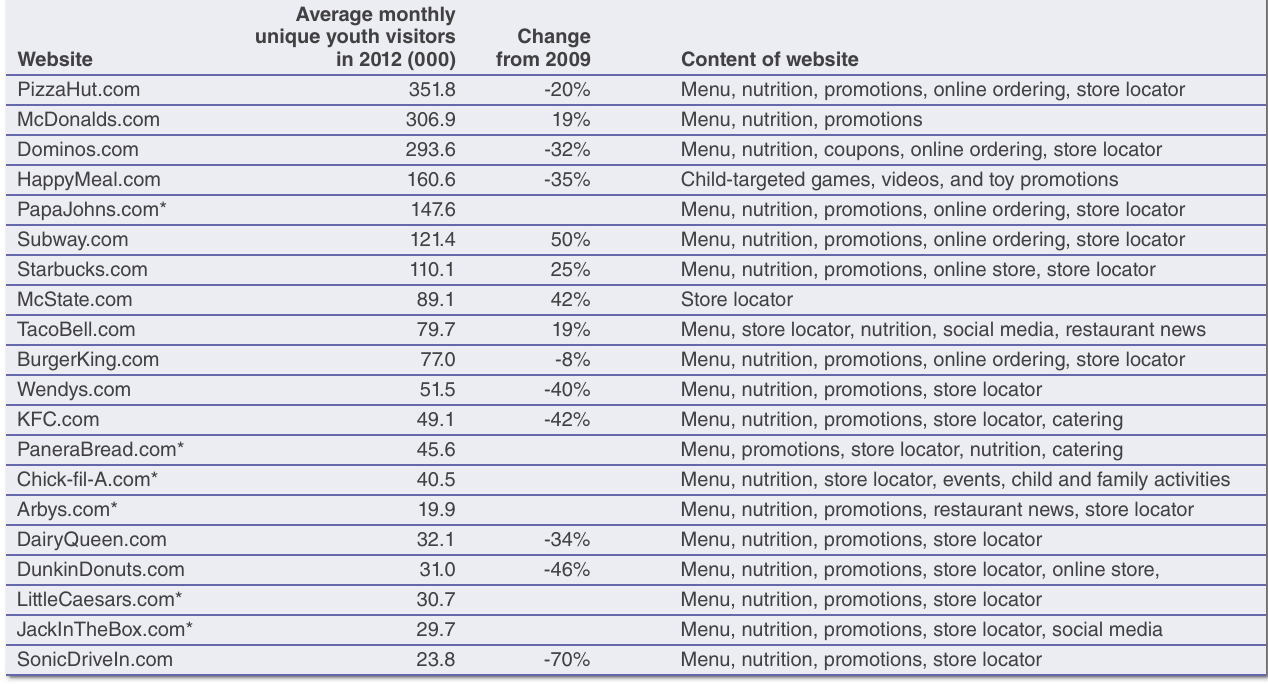
Table 25. Twenty fast food restaurant websites with the most youth visitors